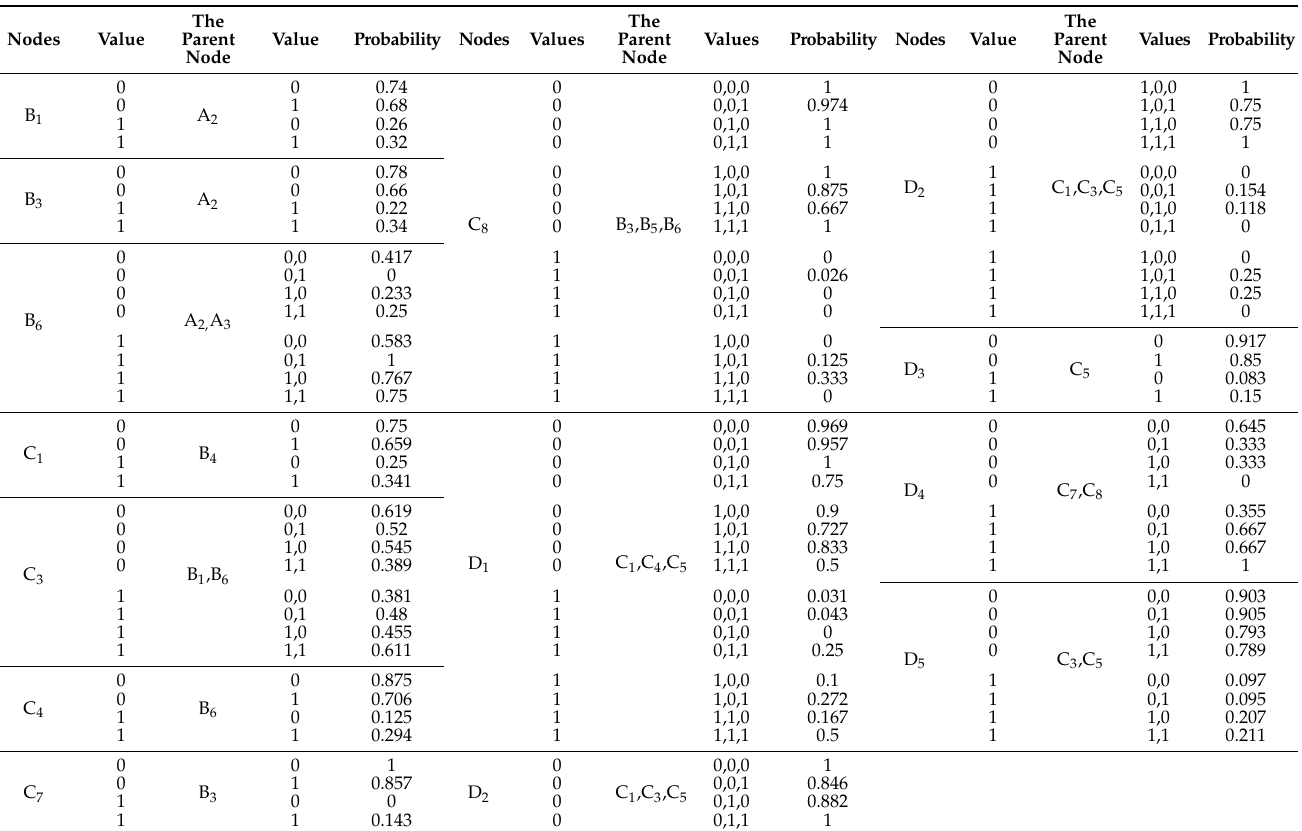
Table 8. Conditional probability